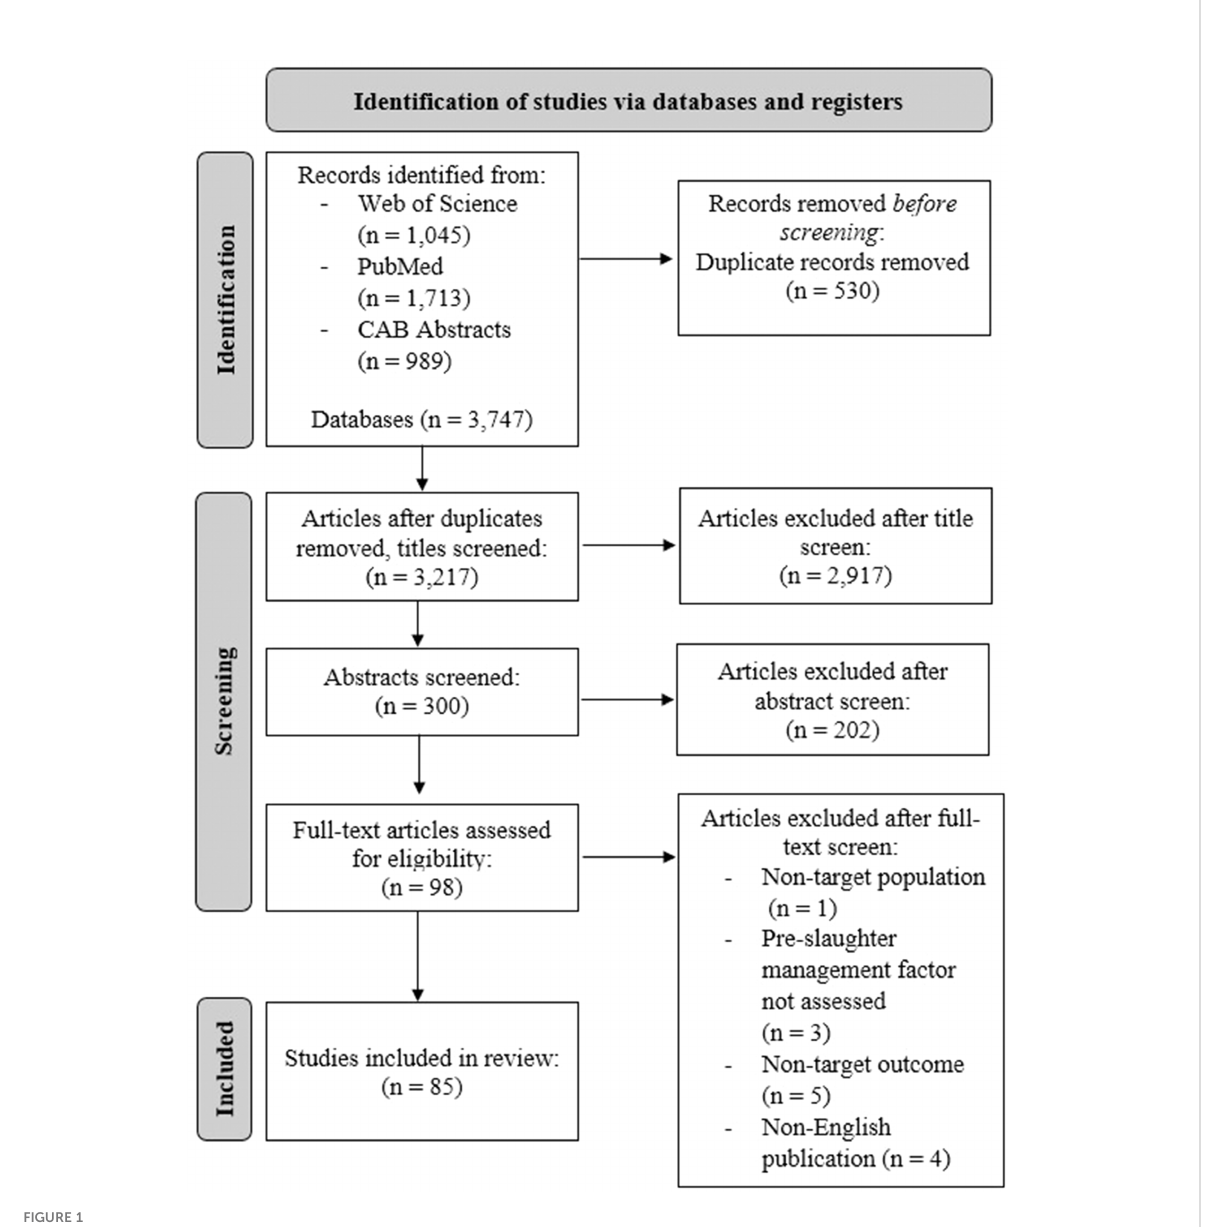
FIGURE 1 A PRISMA fl ow chart depicting the inclusion and exclusion of articles through three rounds of screening. The fi nal number of articles included in the review is also